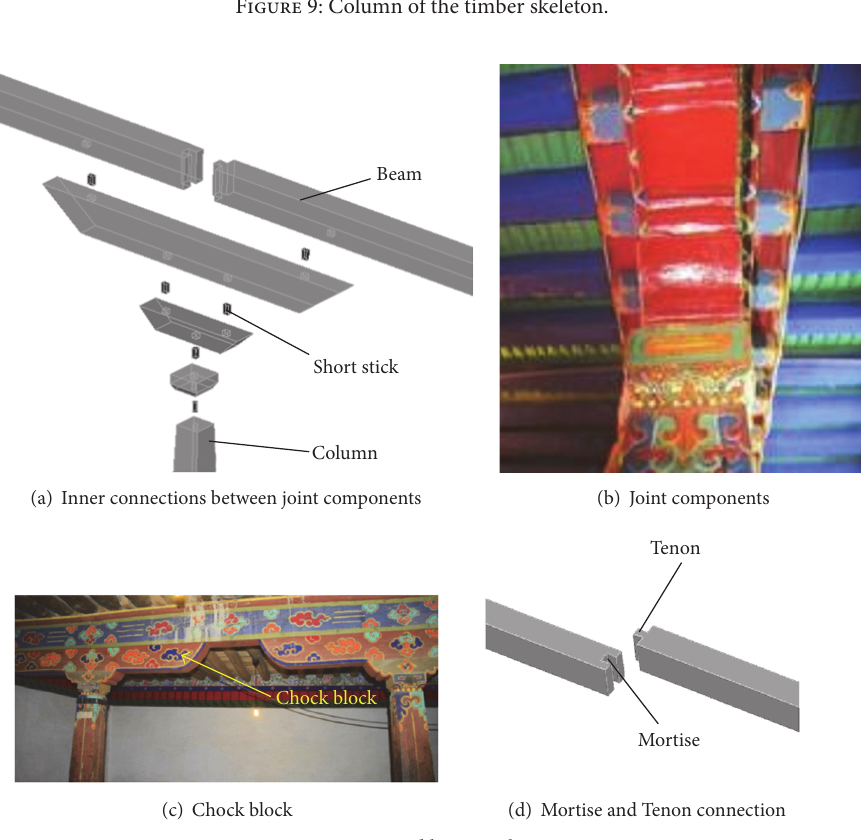
Figure 9: Column of the timber skeleton.